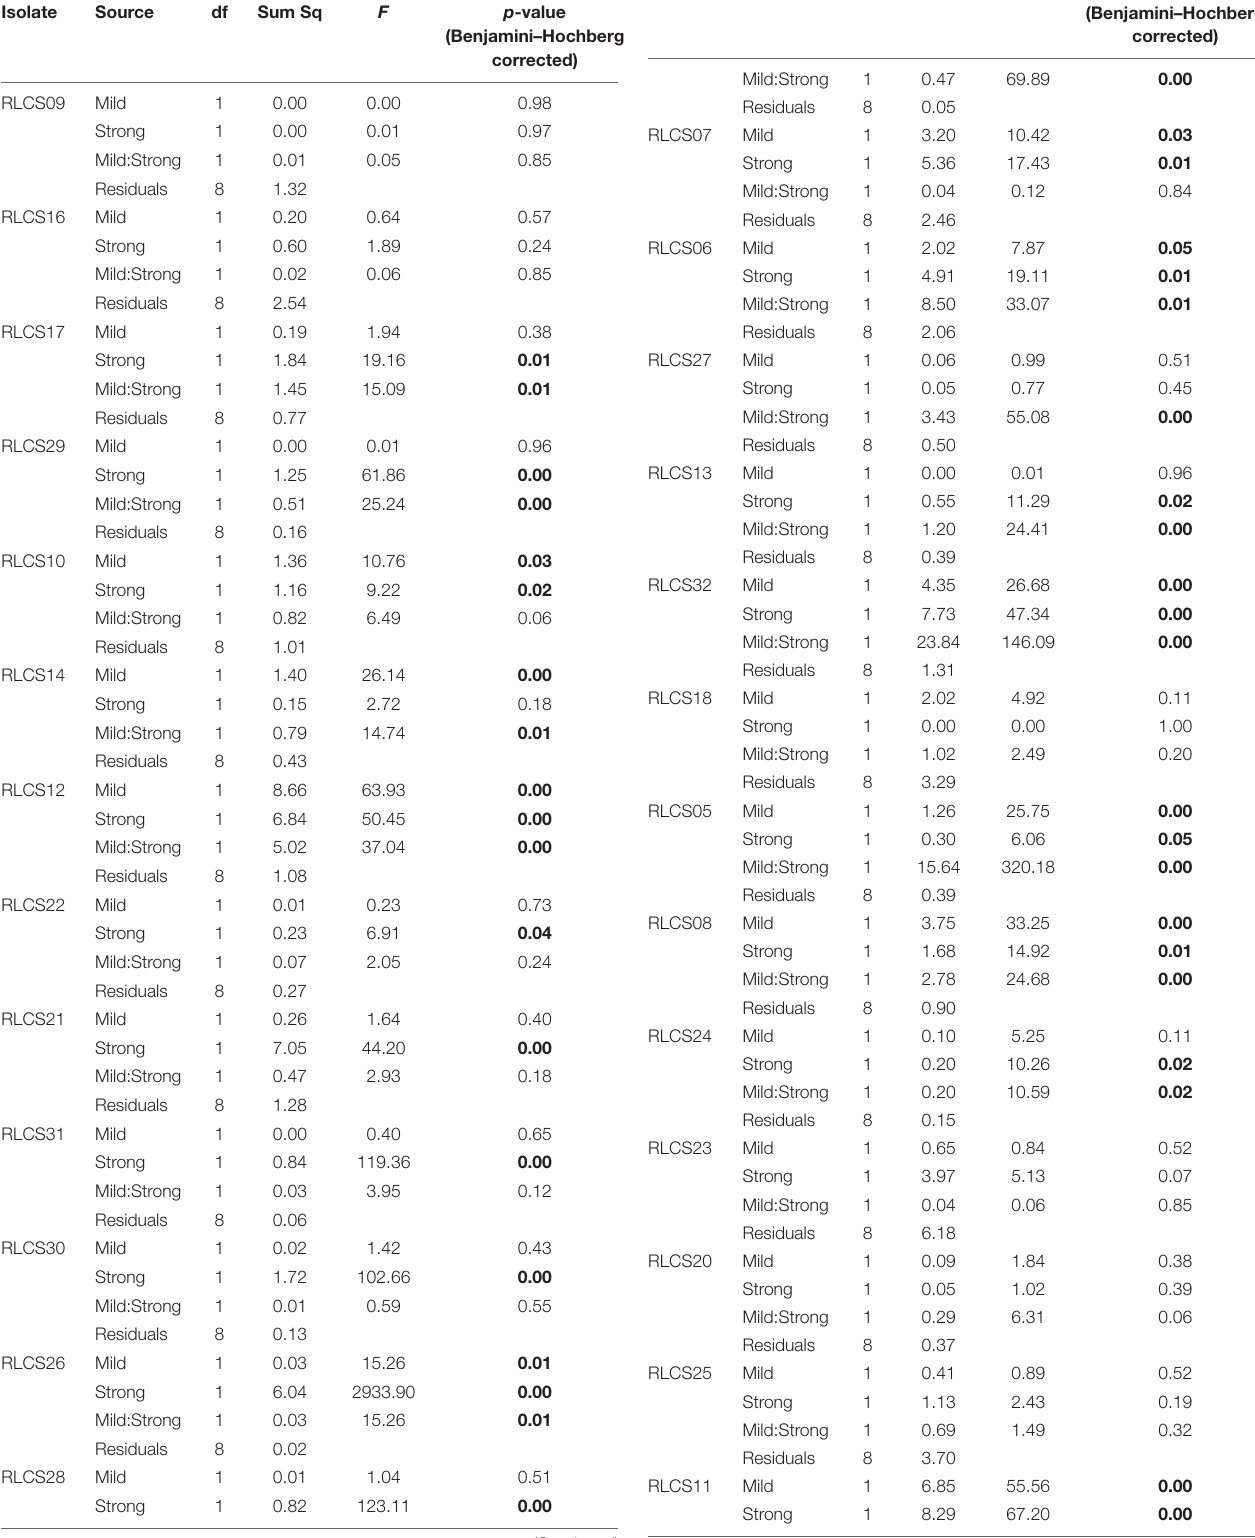
TABLE 2 | Analysis of variance results of effects of mild (M, yes/no), strong (S, yes/no), and both heat stress events (MS). Isolate Source df Sum Sq F p -value